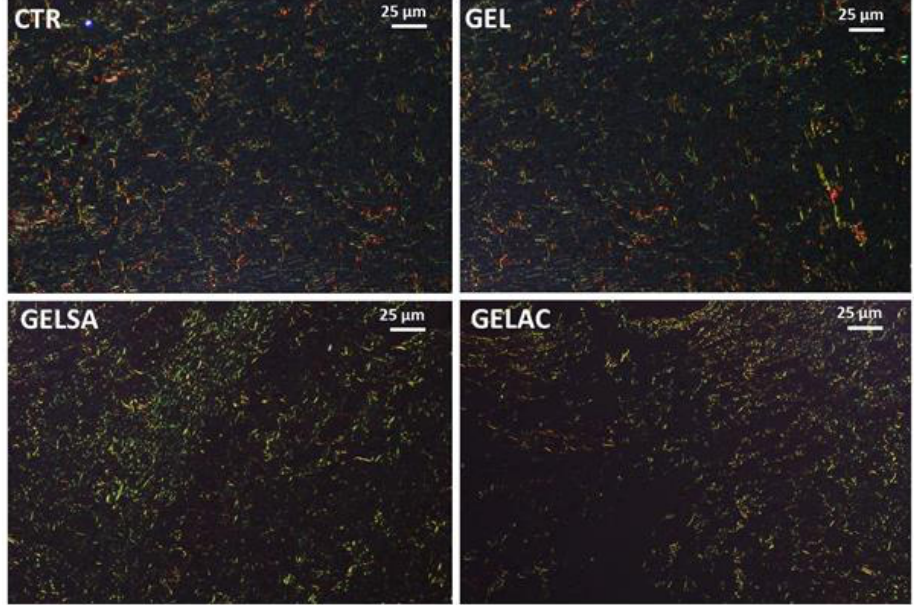
Figure 15. Photomicrographs of histological sections stained in picrosirius and analyzed under polarized light representative of the 3-day repair process. All groups present thin and short collagen fibrils with greenish-yellow birefringence compatible with type III collagen, arranged in a reticular pattern; the interfibrillar spaces (dark) were large and abundant (400×). Caption: CTR — control group; GEL — group treated only with gelatin biomembranes; GELSA — group treated with gelatin biomembranes containing S. adstringens extract; GELAC — group treated with A. cochliacarpa extract.